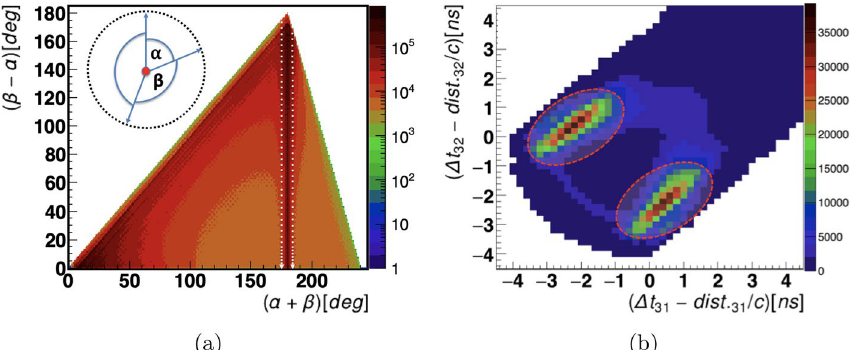
Fig. 7 a The sum of the two smallest versus their differences angular correlations between the registered 3 hits are plotted event‑wise. The number of events in a given pixel is shown in a logarithmic scale. The vertical white dashed lines indicate the region around 180 degree selected as events corresponding to two primary back to back 511 keV photons ( α + β 180 0 ) and one scatter photon. b Shows the results of the calculated = scatter test. The elliptical dashed red lines show the regions used to assign the scattered photon (3 in Fig. 6) to the primary photon. The maximum centered around coordinate ( − 2,0 ) indicates the events when photon 2 was scattered, while the maximum centered around ( 0, − 2 ) corresponds to the events in which photon 1 was